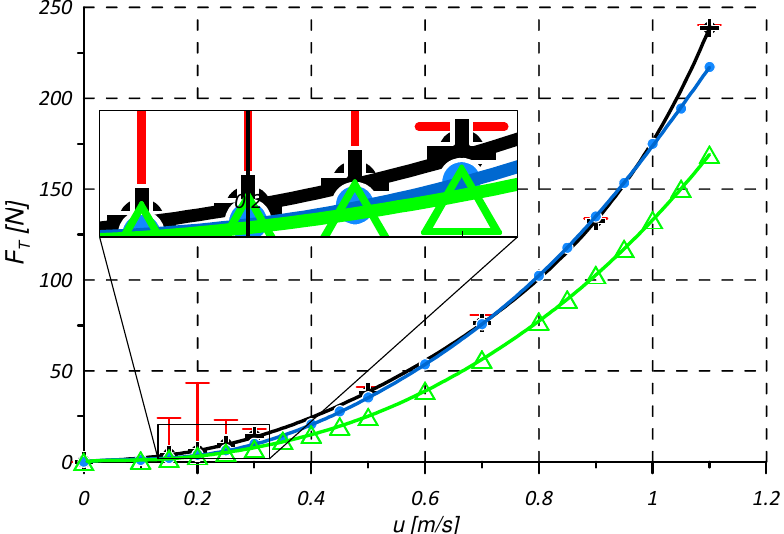
Figure 8. Total resistance F T : Experiments T = 0.95h (+), CFD T = 0.95h ( • ), CFD T = 0.8h ( (cid:52) ), the red bar is the uncertainty.